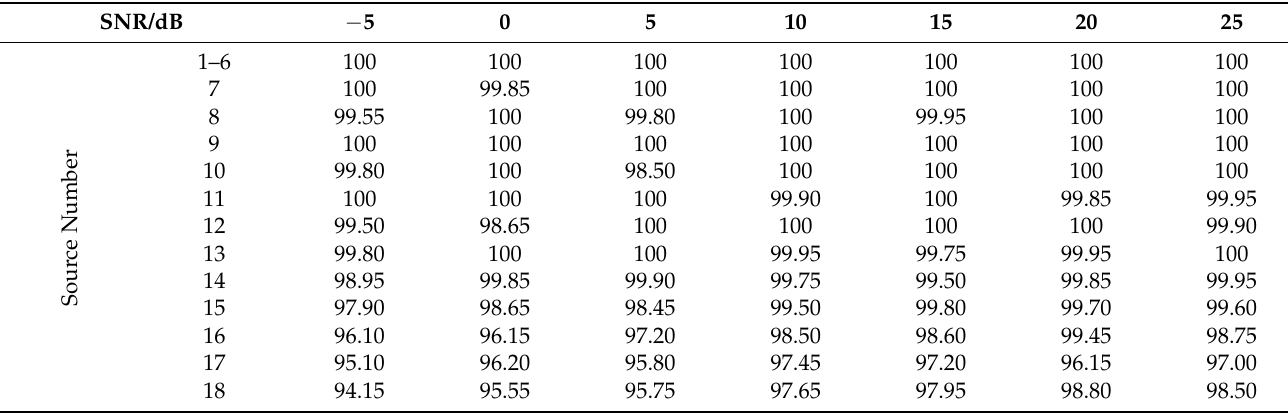
Table 2. Accuracy of ULA source number estimation at different